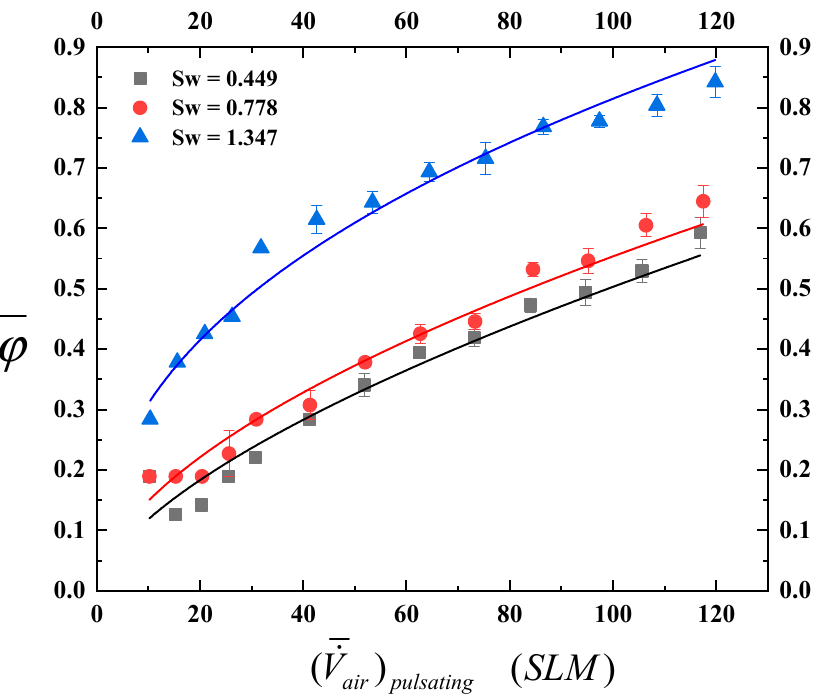
Figure 12. The lean blowout limits in plasma-pulsating flow mode.